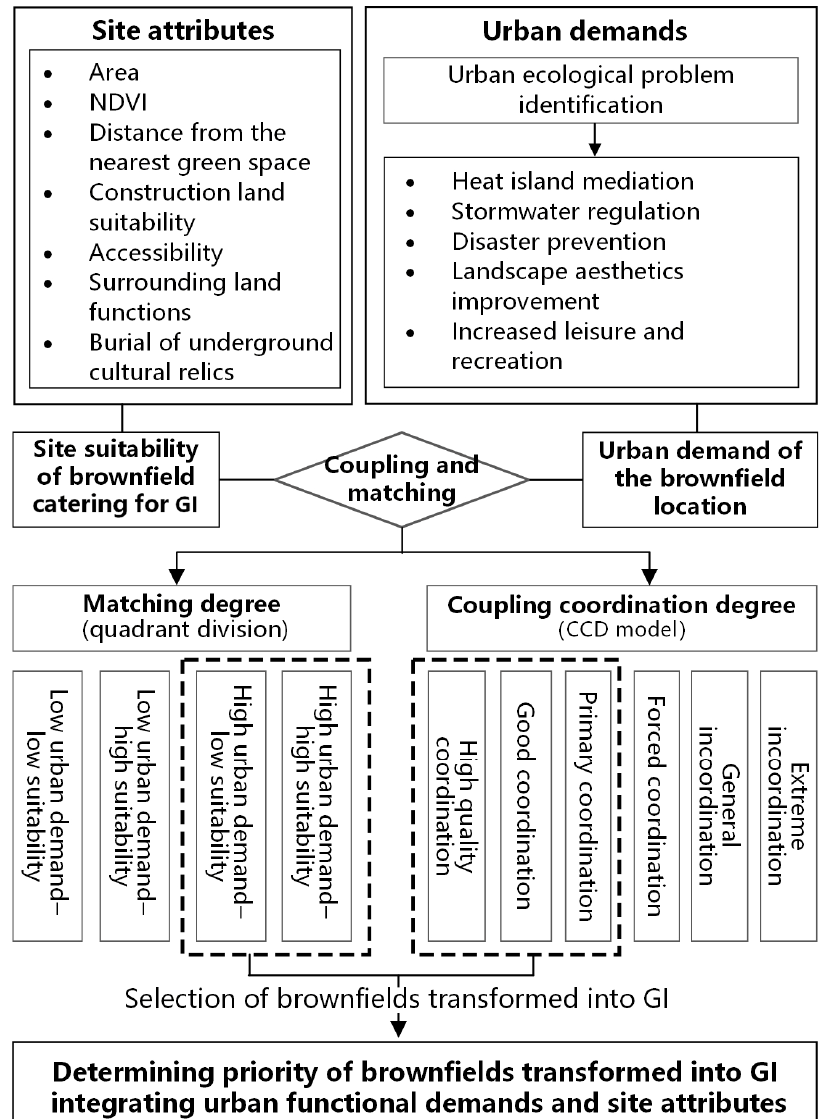
Figure 1. Technical and methodological framework.